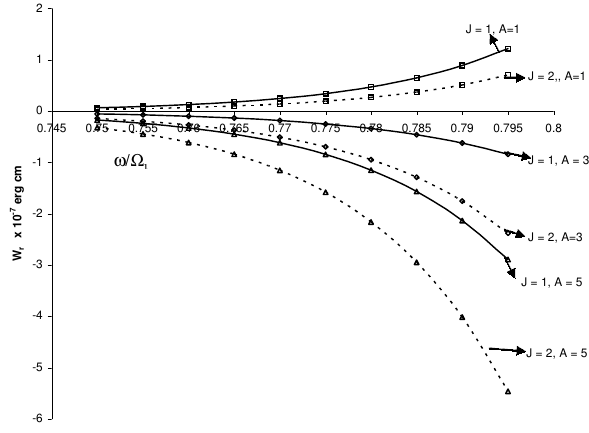
Fig. 5. Variation of perpendicular resonant energy W r ⊥ erg cm versus wave frequency ( ω / (cid:127) i ) for different values of anisotropy (A) and distribution index J =1, 2, V D = − 3 × 10 7 Fig.5 Variation of perpendicular resonant energy W r ^ erg cm versus wave frequency ( w / W i ) for different values of anisotropy (A) and distribution index J= 1,2 V D = -3 x 10 7 cm/sec.